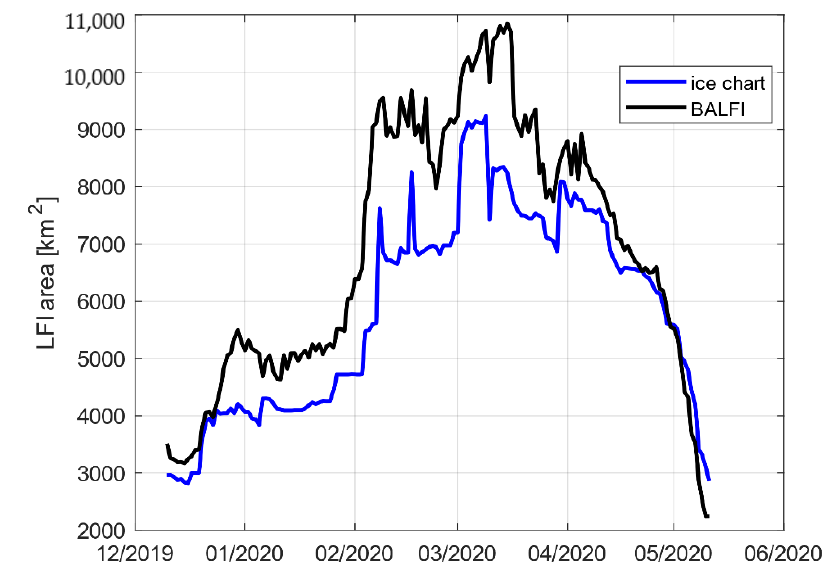
Figure 9. Time series of the Baltic Sea landfast ice area from the BALFI product and FIS / SMHI ice chart for the ice season 2019 – 2020.